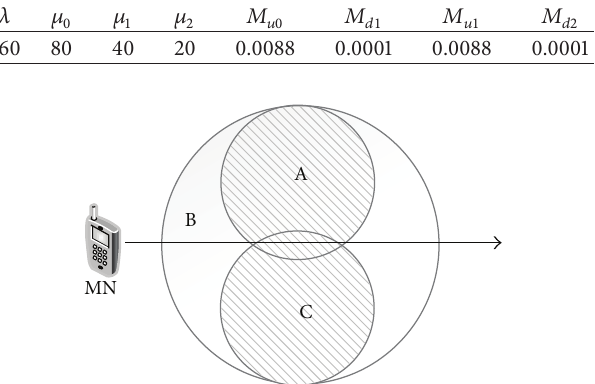
Figure 4: Linear mobility example with overlapping networks.